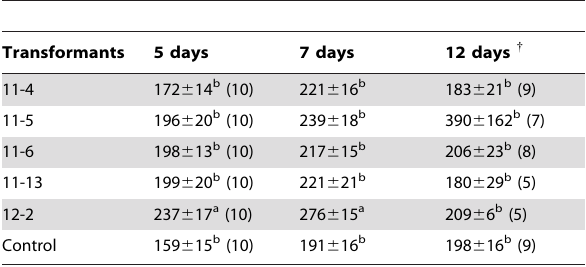
from N. benthamiana BvSTI T2 homozygous plants.